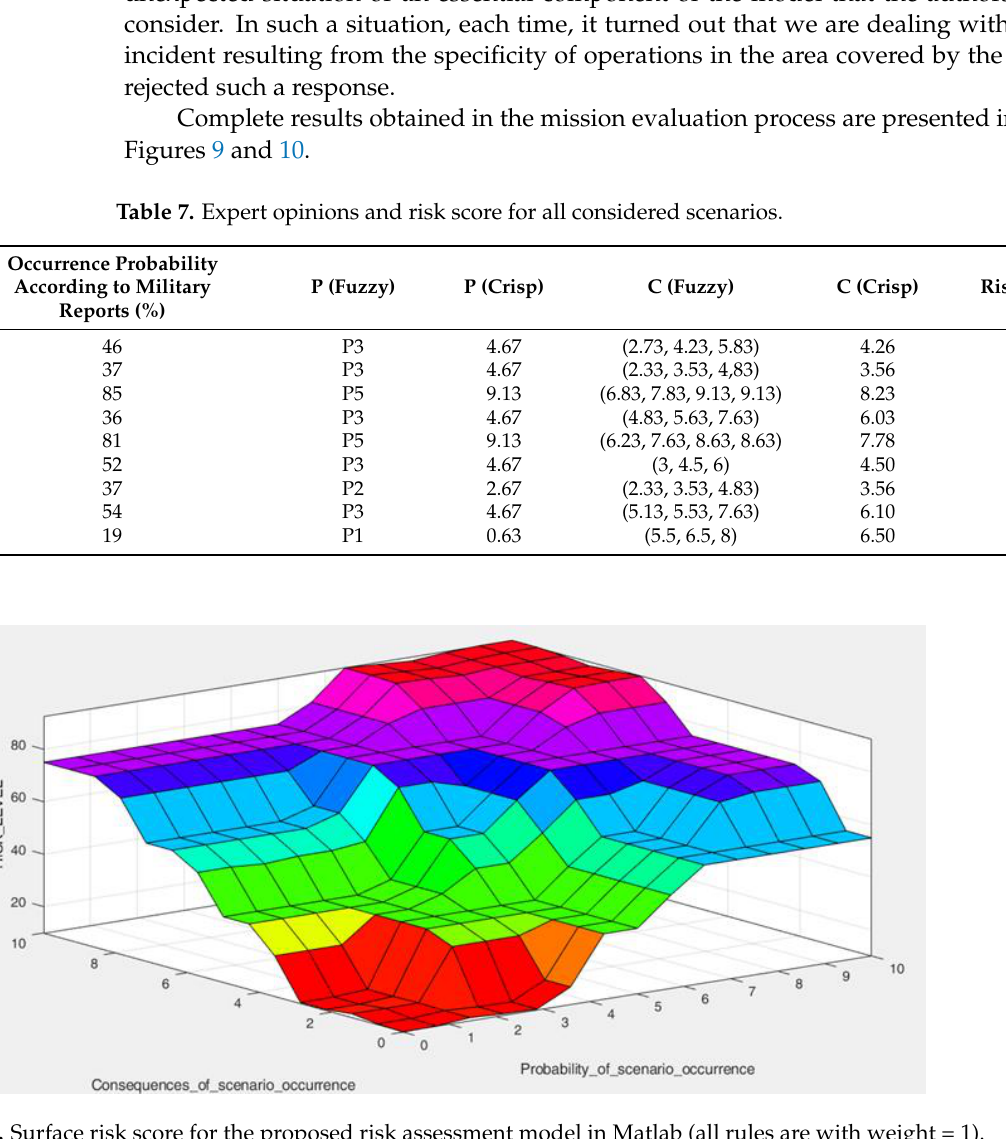
Figure 9. Surface risk score for the proposed risk assessment model in Matlab (all rules are with weight = 1).